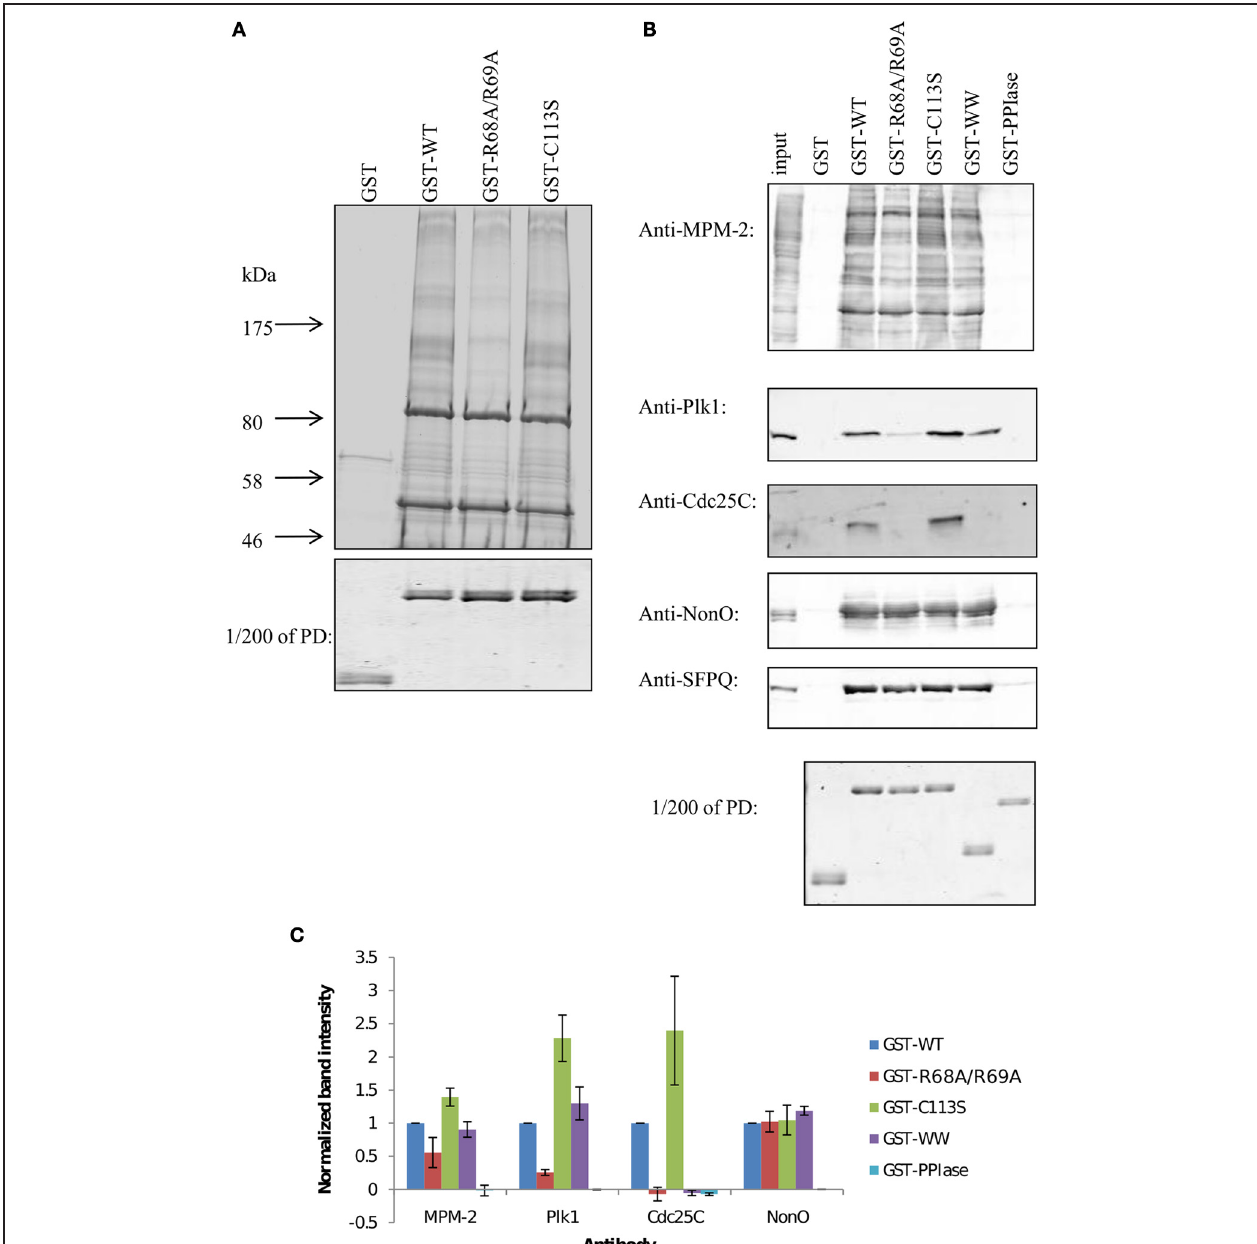
(A) with 1mg of HeLa lysate. Interacting proteins were run on 10% SDS-PAGE, transferred to PVDF and blotted with the indicated antibody. To better compare theamountoffusionprotein onthebeads,1/200ofeachpull-downwasrunona gel and stained with Coomassie Blue (PD). (C) Quantification of blots shown in (B) .Resultsarethemeanofthreeindependentpull-downexperiments ±